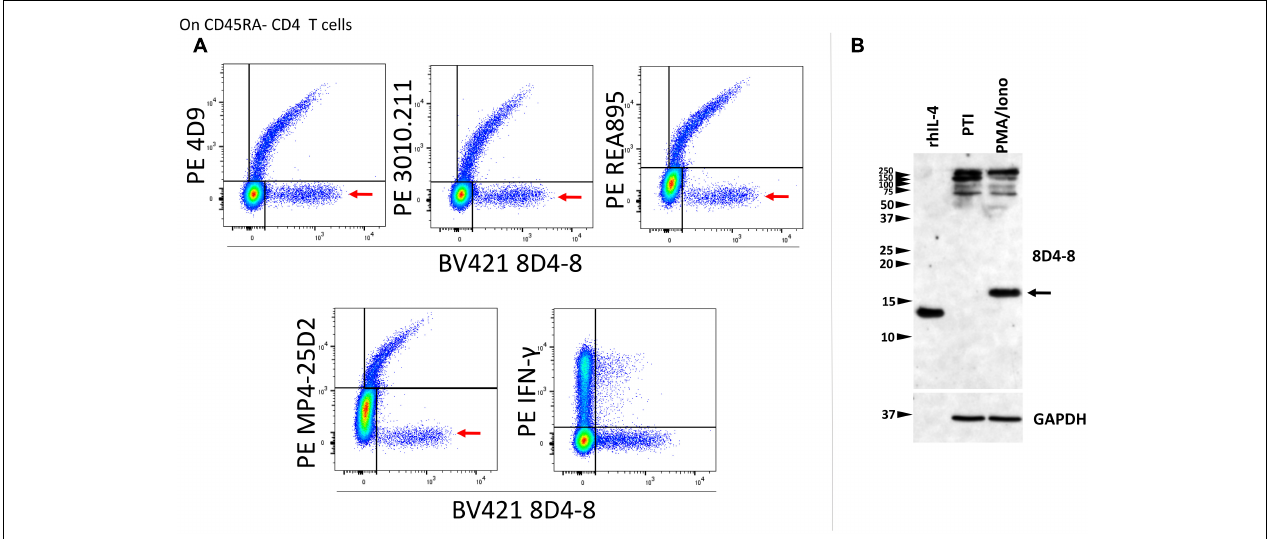
FIGURE 3 | Clone 8D4-8 detects IL-4, yet also identifies a unique target. CD45RA − CD4 T cells were identified as CD45RA − , CD4 + , CD8 − , CD3 + , singlet events (not shown). (A) When co-labeled with other IL-4 clones, 8D4-8 detects 2 populations of cells: one which is apparently IL-4 and another unknown target which is limited to 8D4-8. Importantly, clones 4D9, 3010.211, REA895, and MP4-25D2 do not detect unique populations. 8D4-8 was also compared with IFN- γ as a control. Data shown are representative of 3 separate experiment from 3 donors. (B) Western blotting of recombinant human IL-4 (rhIL-4), protein transport inhibitor (PTI)-treated, and PMA/ionomycin with PTI − treated cell lysates demonstrate 8D4-8 is capable of detecting recombinant IL-4 as well as natural IL-4 (black arrow). Multiple high molecular weight bands are present in both treatments. Western blot data are representative of 5 stimulations and experiments from 5 donors.